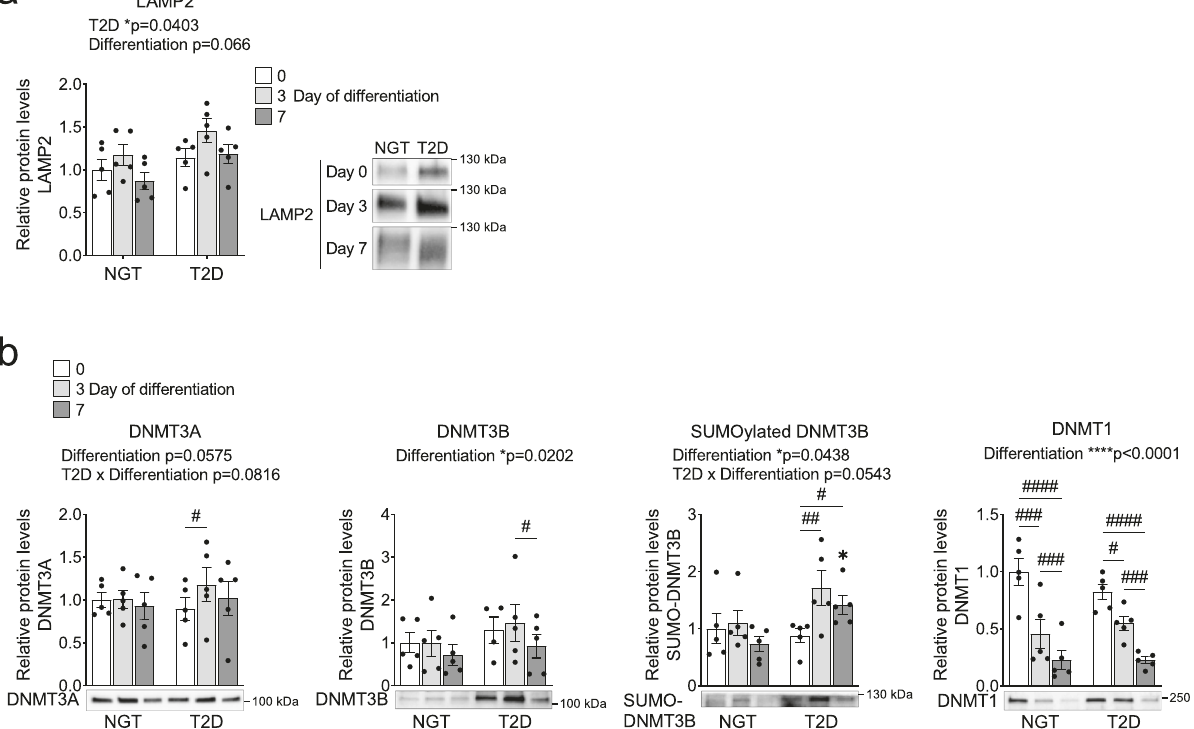
Fig. 6 Impact of T2D on LAMP2 and DNMTs during myogenesis in human muscle cells. a – b Protein levels (Western blot) of LAMP2 ( a ), and DNMT3A, DNMT3B, SUMOylated DNMT3B, and DNMT1 ( b ) in muscle cells from individuals with type 2 diabetes (T2D) and controls (NGT normal glucose tolerance) at day 0 (white bars), 3 (light gray bars), and 7 (dark gray bars) of differentiation. n = 5 individuals per group (except for DNMT3B, T2D: Day 0 where n = 4). NGT at day 0 is set to 1. Representative blots are shown. # q < 0.05, ## q < 0.01, ### q < 0.001, #### q < 0.0001 for comparisons between time points within each group, and * q < 0.05 for T2D vs. NGT at each time point. DNMT3A: q = 0.0305 (T2D: Day 0 vs. 3), and DNMT3B: q = 0.0323 (T2D: Day 3 vs. 7), and SUMO-DNMT3B: q = 0.0073 (T2D: Day 0 vs. 3), q = 0.0157 (T2D: Day 0 vs. 7), q = 0.0237 (Day 7: T2D vs. NGT), and DNMT1: q = 0.0003 (NGT: Day 0 vs. 3), q = 0.0009 (NGT: Day 3 vs. 7), q = 0.0000005 (NGT: Day 0 vs. 7), q = 0.0457 (T2D: Day 0 vs. 3), q = 0.0003 (T2D: Day 3 vs. 7), q = 0.0000097 (T2D: Day 0 vs. 7). Bars represent mean values and error bars display SEM ( a – b ). The effects of T2D and